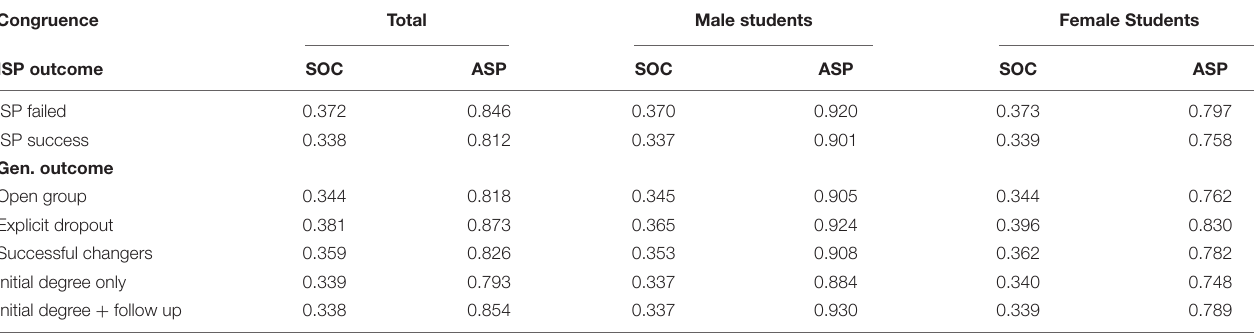
Successful changers